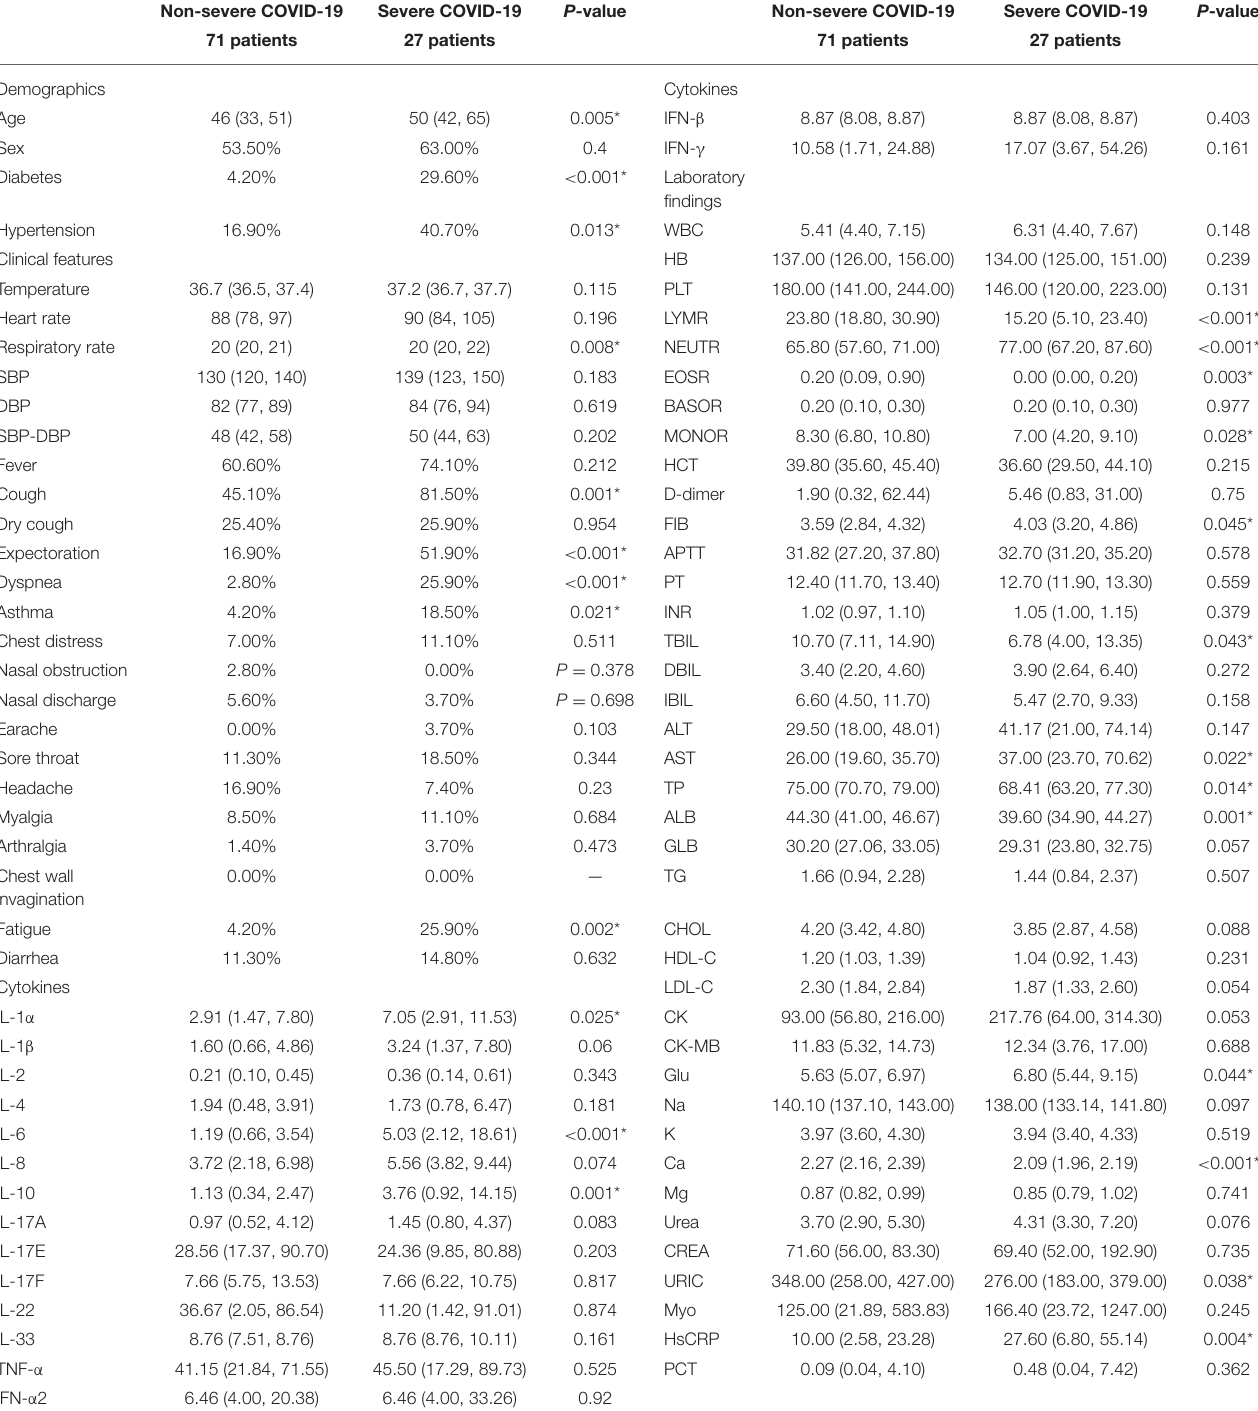
TABLE 1 | Patients’ characteristics in training set. Non-severe COVID-19 Severe COVID-19 P -value Non-severe COVID-19 Severe COVID-19 P -value